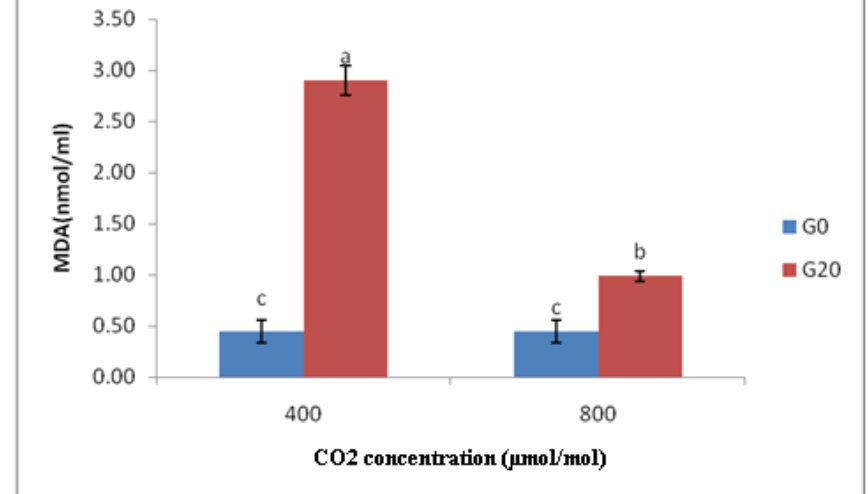
Figure 6. MDA content in different CO accessions of C.asiatica ; n = 2 (400 = Ambient CO concentration; G0 = Control; G20 = Plants irradiated to 20